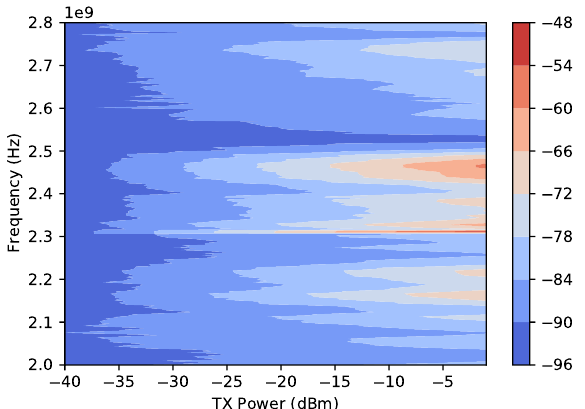
Figure 7. Harmonic response with varying transmitted (input) signal power. Power levels were tested in steps of 0.5 dBm between − 20 and − 7 dBm.